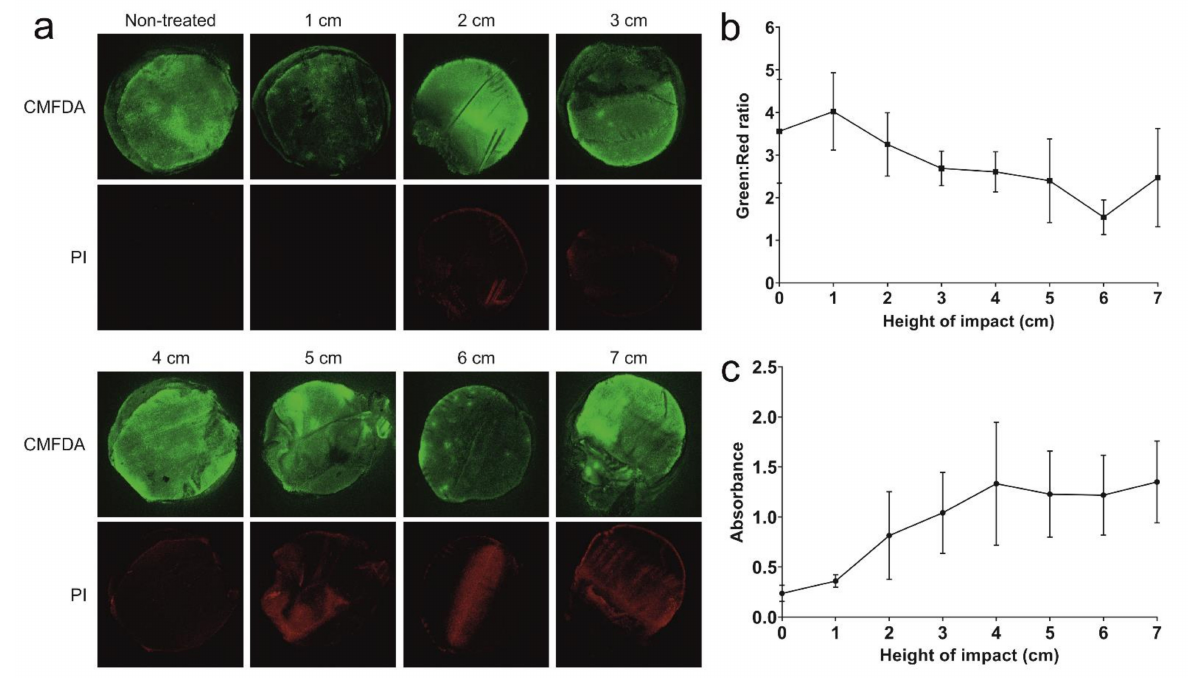
Figure 1. Establishment of a single-impact trauma model for porcine explants. ( a ) Representative macro-confocal images of porcine articular cartilage explants 72 h after impact with a 500 g weight dropped from varying heights. Viable cells shown in green (CMFDA) and dead cells in red (PI). ( b ) Quantification of green:red (live:dead) ratio from impact experiments shown in ( b ) ( n = 3 ex- plants). ( c ) LDH release from explants 72 h after impact with a 500 g weight dropped from varying heights ( n = 3 explants). Graphs show mean +/ −